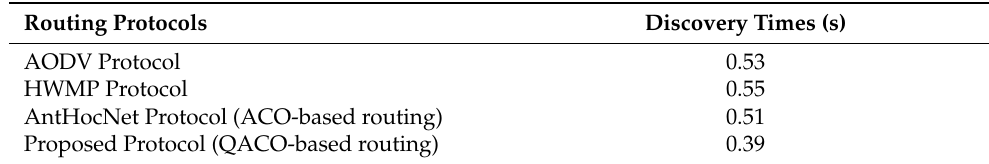
Table 3. Initial discovery time for distinct routing